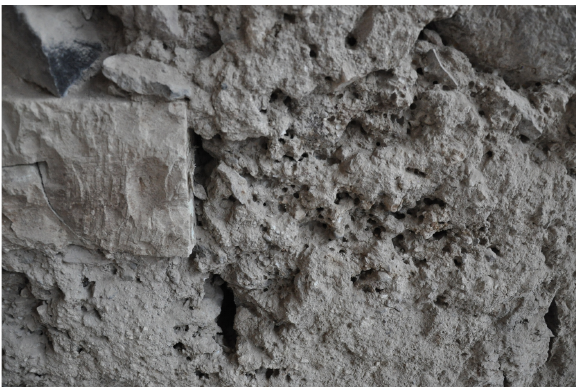
Figure 2: Holes dug into a prehistoric wall at Akrotiri by mud dauber wasps in search of clay, undermining the wall’s stability.